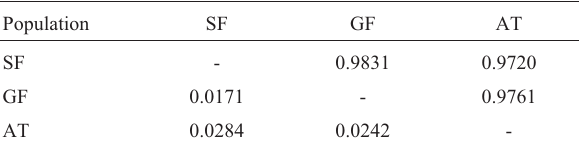
Table1 -UnbiasedNei’s(1978)geneticdistances(lower-left)andgenetic identity (upper-right) between pairs of three Eufriesea violacea populations from São Francisco State Park (SF), Godoy’s Forest State Park (GF) and the Arthur Thomas Municipal Park (AT).